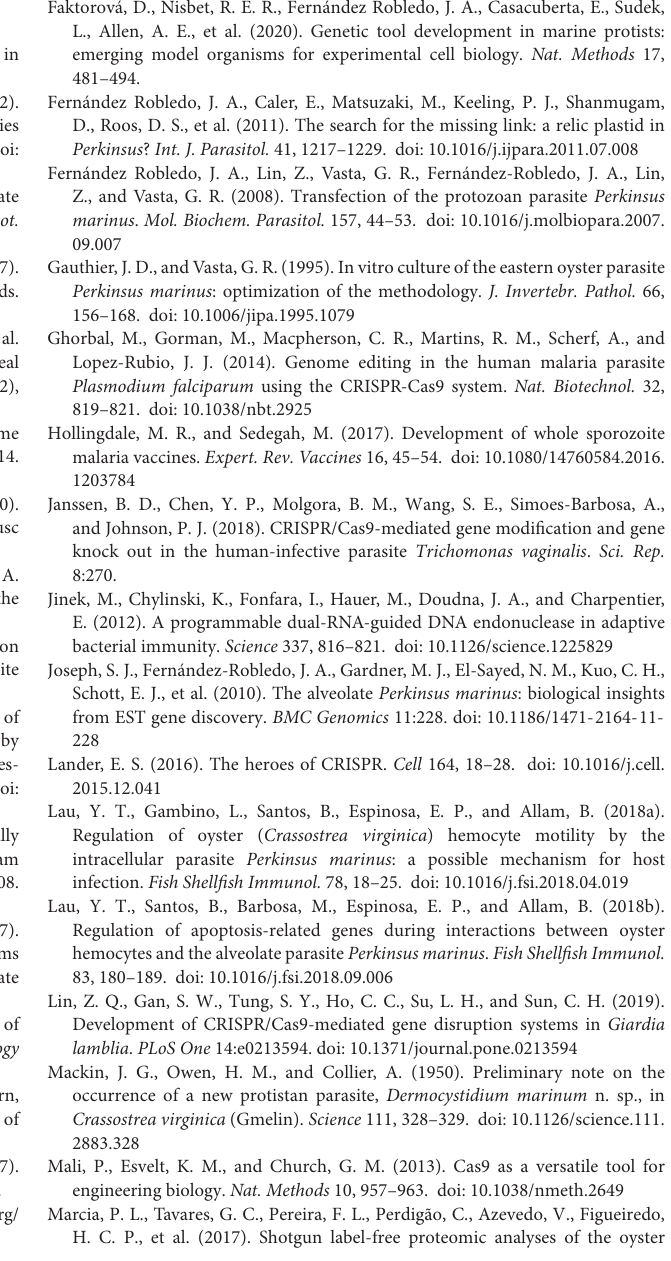
Supplementary Figure 1 | Cell number optimization studies. Supplementary Figure 2 | PCR and nested PCR based genotyping of PMAR_Pmar027036 for the GFP knock in analysis. The genomic DNA was isolated from two different clones labeled as 4 and 5, which were hand-picked 3 months after the cell sorting from the experiments involved in the utilization of SgRNA-1 and SgRNA-2, respectively. (A) The PCR product showing the successful amplification of 2,600 bp of DNA sequencing containing flanking regions, MOE1 CDS encoded by PMAR_Pmar027036 and the GFP. PCR product was diluted 100 times and used in the nested PCR to identify the knock in of